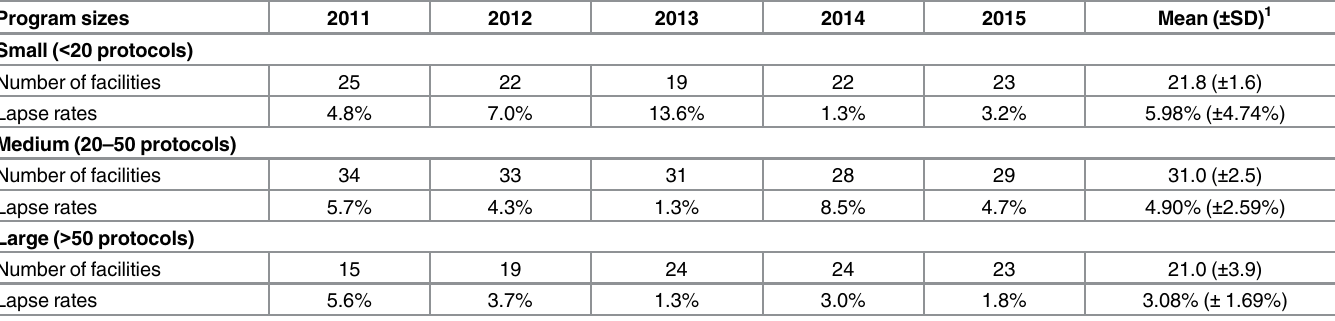
Table 3. Lapse in institutional animal care and use committee continuing reviews according to program sizes. Program